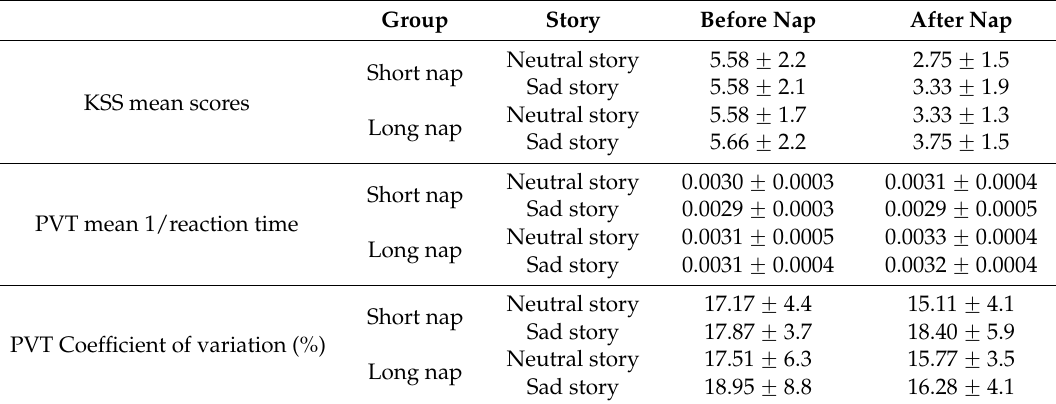
Table 3. Sleepiness and vigilance before and after the naps.